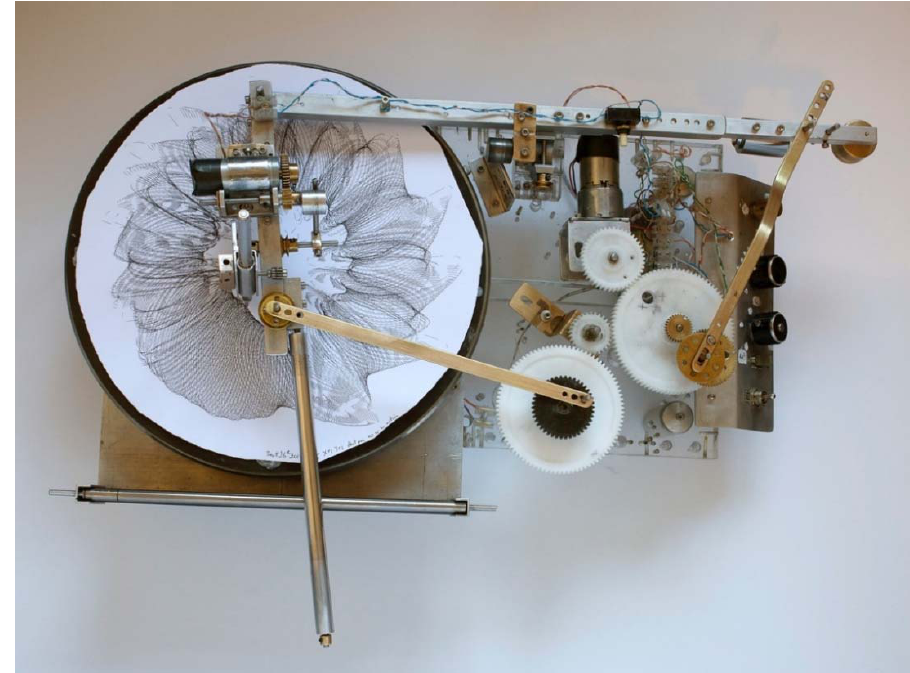
Figure 5. New Turntable machine referred to below as NTT.